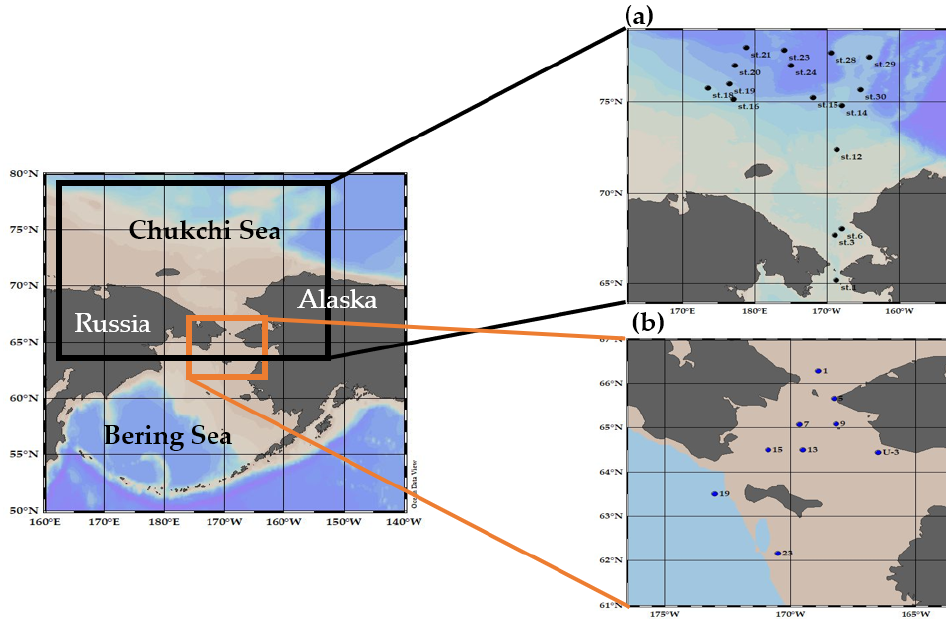
Figure 1. Sampling locations of ( a ) ARA07B and ( b ) OS040 cruises. Table 1. Sampling locations in the Northern Bering and Chukchi Seas.